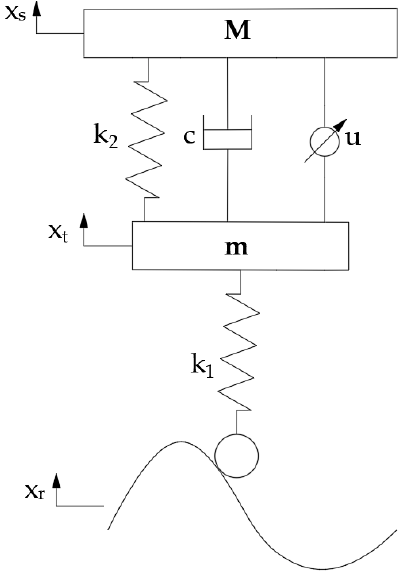
Figure 1. 2-degree-of-freedom 1/4 active suspension model.